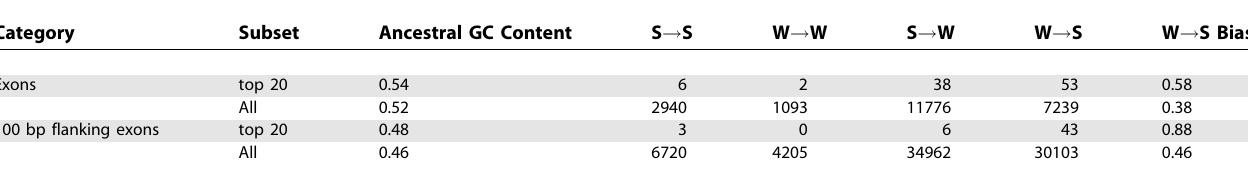
Table 2. Patterns of Nucleotide Substitution in Exons with High Divergence Compared to the Remaining Exons of the Same Gene